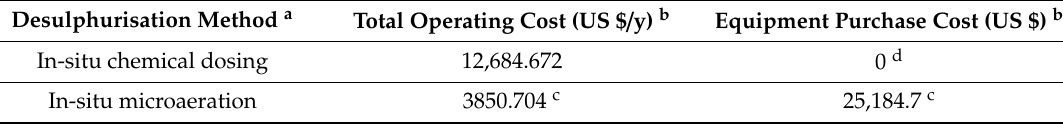
Table 3. Literature obtained equipment purchase cost and operating cost for desulphurisation processes of in-situ chemical dosing and in-situ microaeration desulphurisation approach [32]. Desulphurisation Method a